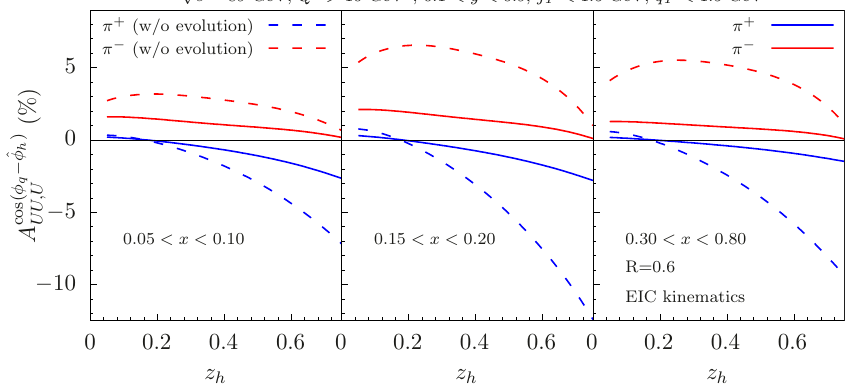
ˆ φ h ) Figure 5 . Numerical results of A cos( φ q − as a function of hadron momentum fraction z h for UU,U unpolarized π ± in jet production with electron in unpolarized ep collision predicted for EIC using three different bins of x : [0 . 05 , 0 . 1] , [0 . 15 , 0 . 2] , and [0 . 3 , 0 . 8] . The solid (dashed) curves are the √ calculations with (without) TMD evolution. We apply the center-of-mass energy s = 89 GeV of EIC kinematics, jet radius R = 0 . 6 , Q 2 > 10 GeV 2 , inelasticity y in [0 . 1 , 0 . 9] and both transverse momentum imbalance q T and final hadron transverse momentum in jet smaller than 1 . 5